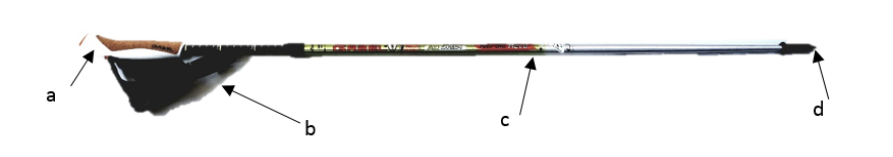
Figure 1. Nordic walking pole: ( a ) handle; ( b ) glove; ( c ) aluminum or carbon fiber body; ( d ) steel